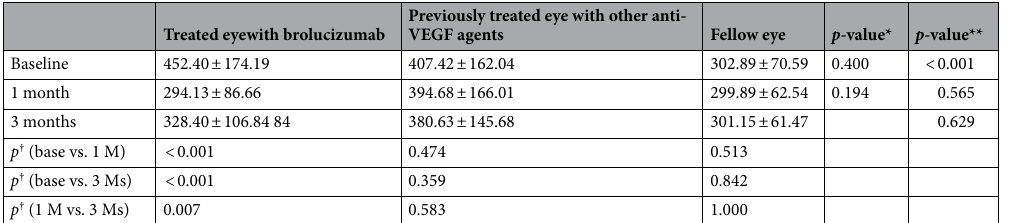
Table 3. Central macular thickness (μm) before and after intravitreal brolucizumab injection. *Comparison between treated eyes with brolucizumab and previously treated eyes during the early phase with other anti- vascular endothelial growth factor (VEGF) agents (Mann–Whitney U -test). **Comparison between treated eyes with brolucizumab and untreated fellow eyes in each period (Mann–Whitney U -test). † Comparison values between the baseline and follow-up visits for each value (Wilcoxon signed-rank test). M, month; base,